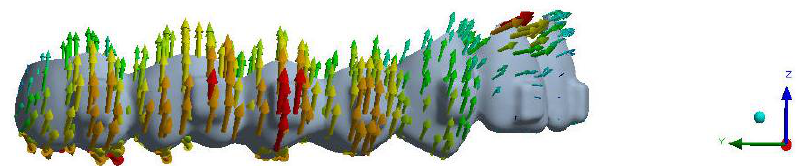
Figure 1. Maximum deformation of the aligner in the analyses on the RETT model. Consequently, aligner deformation was similar for all simulations. A strong tendency for buccal tipping and intrusion was observed at the molar, premolar, and canine levels, while for the incisors, a deformation of the aligners’ gingival margins away from the tooth surfaces was observed.